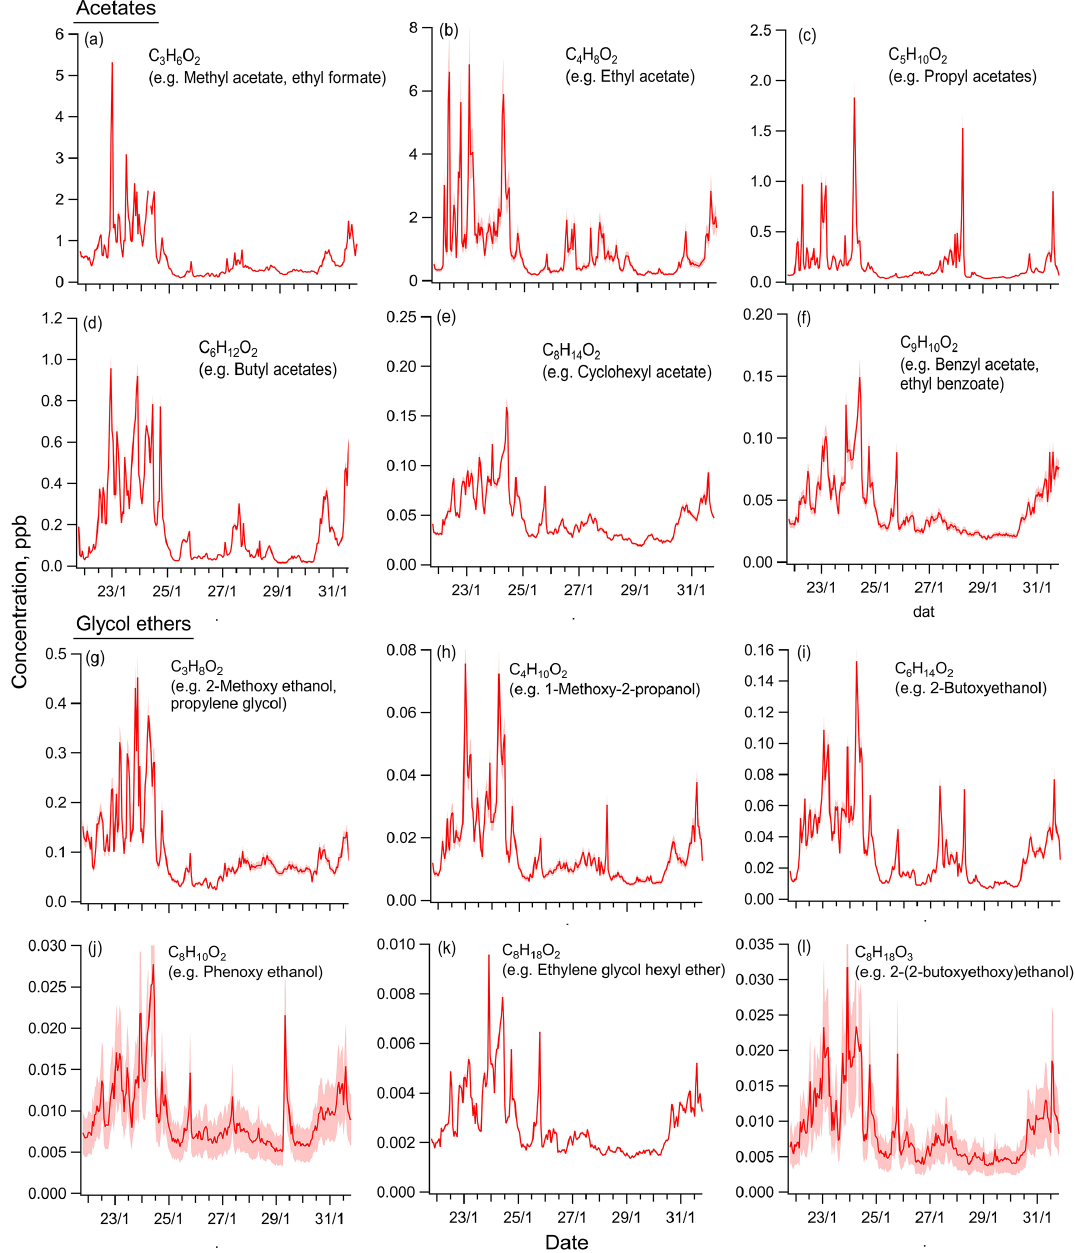
Figure 4. The concentration time series of select, widely used acetates and glycol ethers. Time series are shown with major isomers as examples, with a more comprehensive list available in Tables 1 and S7. Displayed uncertainty bands are a function of calibration uncertainties (including for isomer pairs; Table